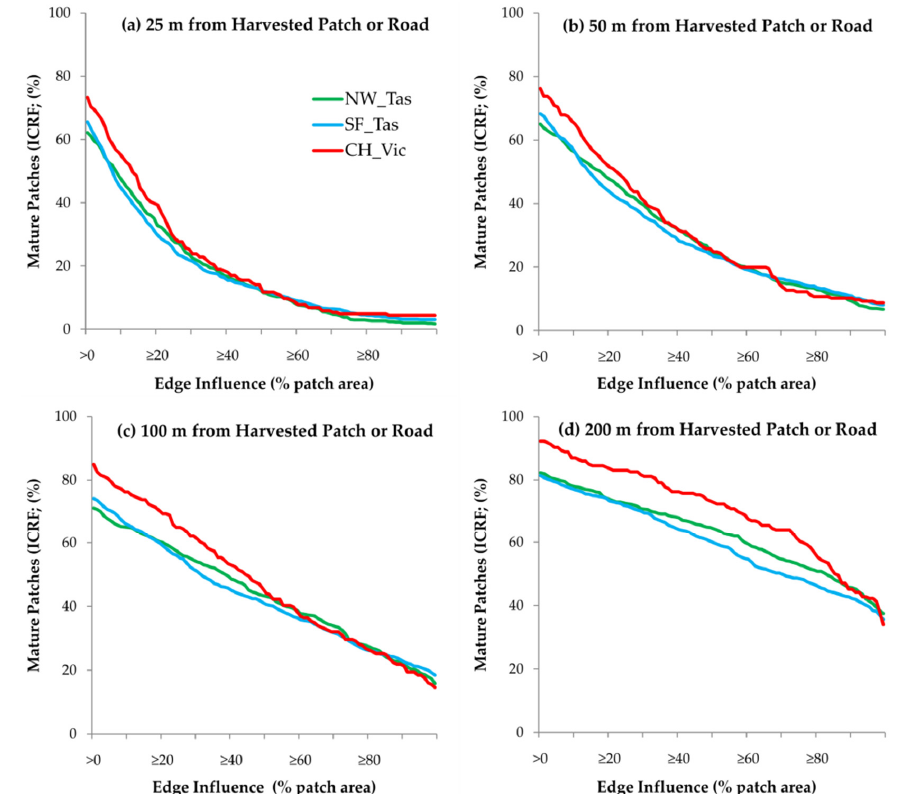
Figure 3. Inverse cumulative relative frequency (ICRF; %) of mature forest patches at different levels of edge influence for three study areas (Southern Forests Tasmania (SF); North West Tasmania (NW); Central Highlands Victoria (CH)). Edge influence is the proportion of a mature forest patch that is within a particular distance of harvested patches or roads: ( a ) 25 m; ( b ) 50 m; ( c ) 100 m; and ( d ) 200 m. For example: in ( a ), 11% of mature forest patches in Southern Forests Tasmania had more than 50% of their patch area within 25 m of a harvested patch or road.